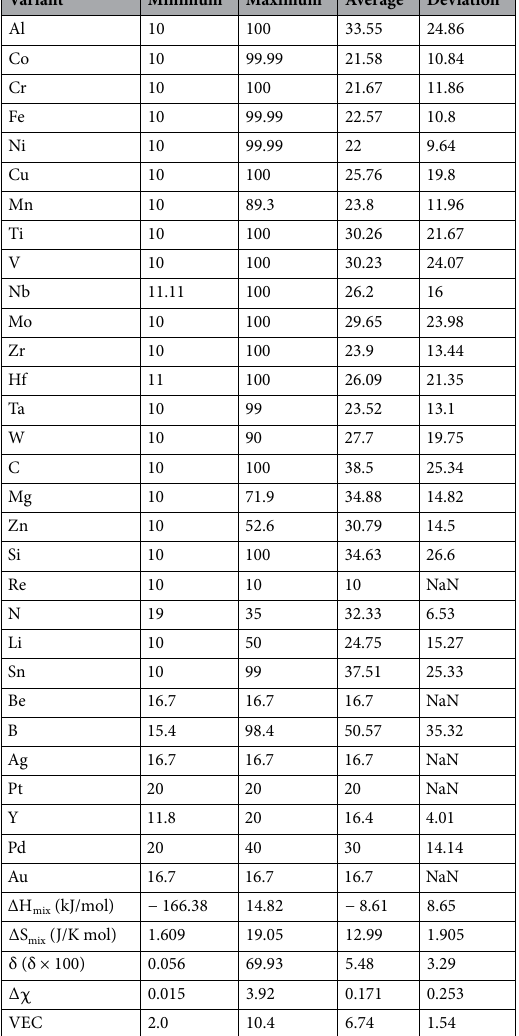
Table 1. Range of composition (atomic weight %) and physical parameters used in this